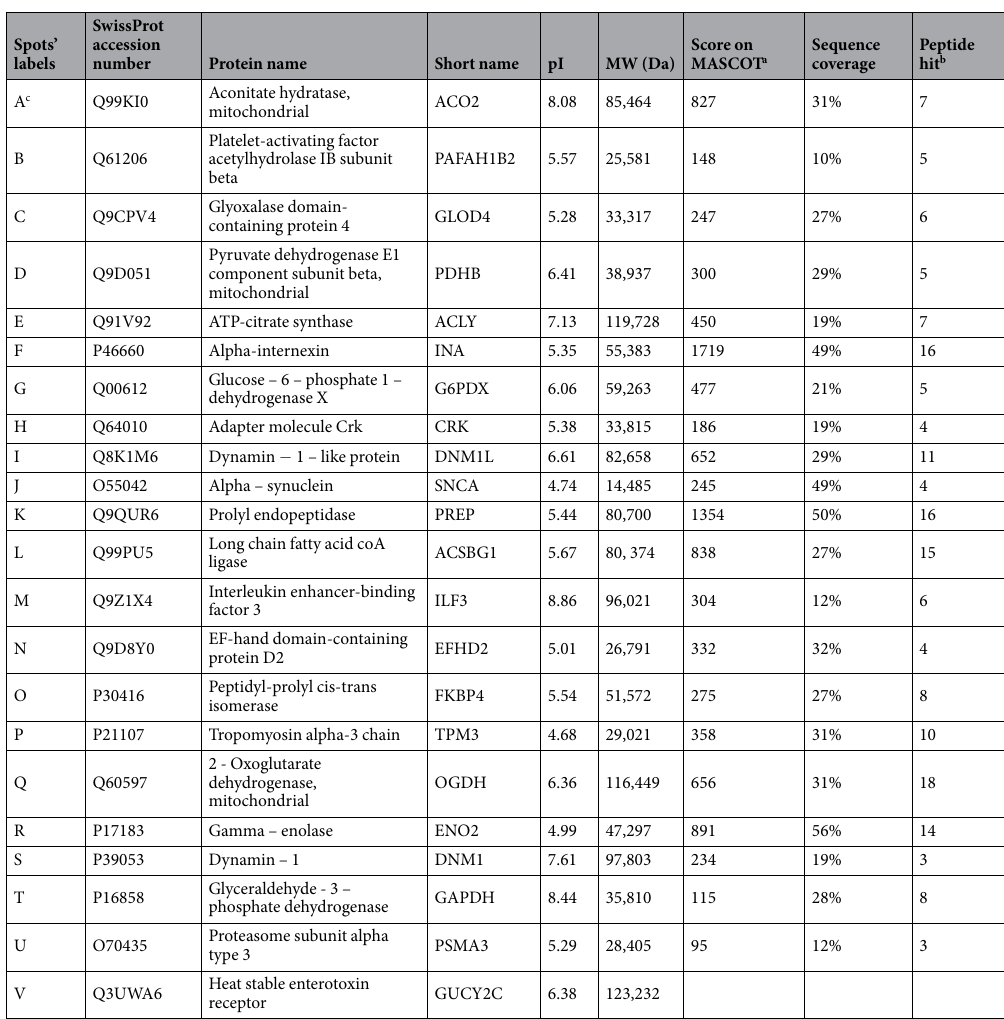
Table 1. Identified proteins altered at d10 and/or d17 in the hypothalamus. Proteins identified at d10 (A-L), at d17 (M-T) and both d10/d17 (U and V). a MASCOT, algorithm that uses mass spectrometric data to identify proteins. b Peptide hit corresponding to unique peptide. c Protein spots corresponding to one protein identification. pI: Isoelectric point; MW: Molecular